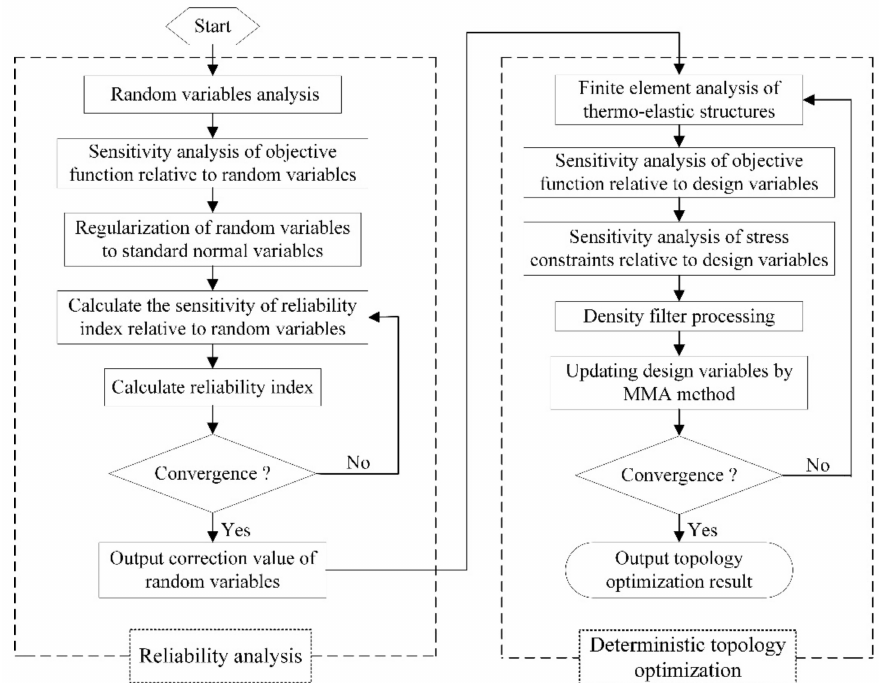
Figure 3. Flowchart of reliability topology optimization in hybrid format.